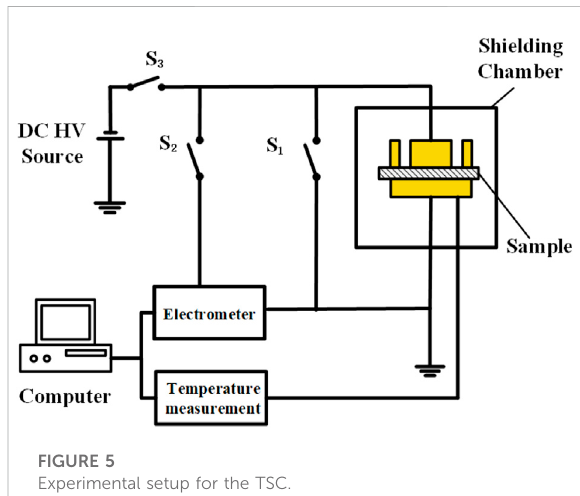
FIGURE 6 Average breakdown strength at different